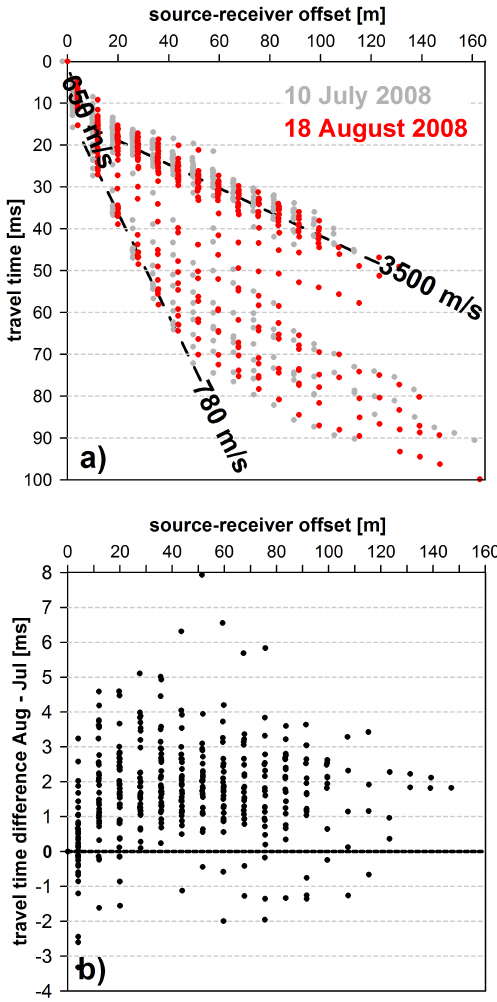
Fig. 5. (a) Travel times from Lapires for 10 July 2008 (grey) and 18 August 2008 (red) (as in Fig. 4), here sorted by the ab- solute offset between geophone and shot point (for better visibil- ity of both data sets the x-axis was slightly shifted to the right for 10 July 2008). (b) Travel time differences between August and July, sorted by source-receiver